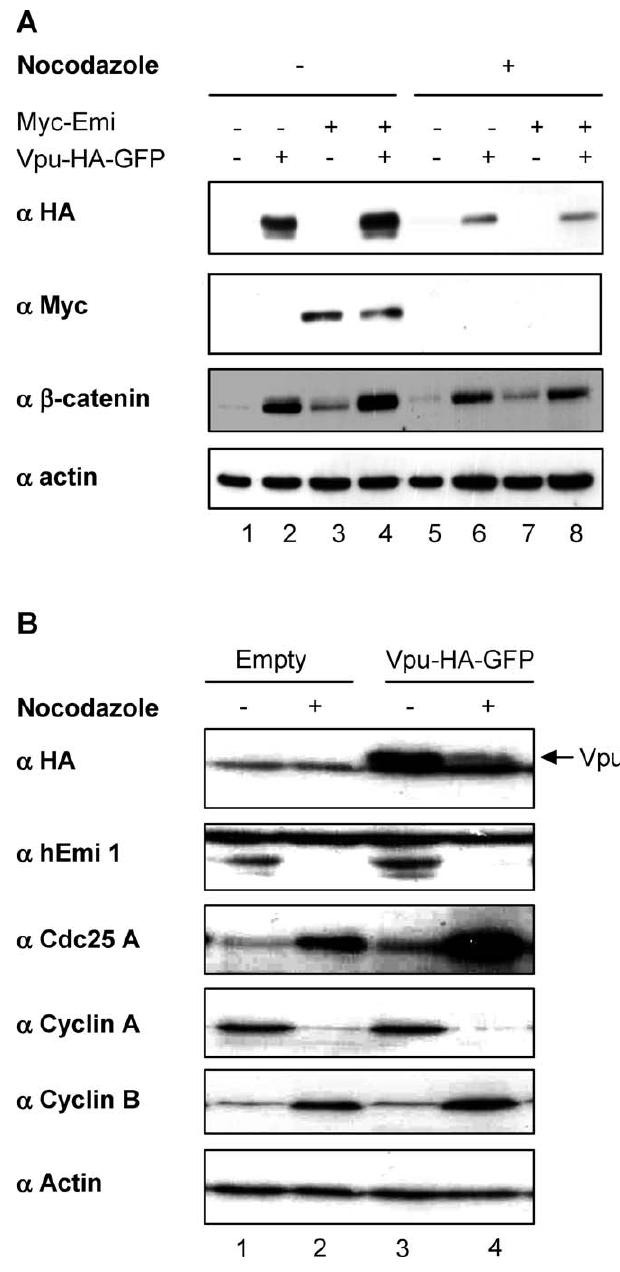
Figure 1. Vpu Is Degraded in Nocodazole-Treated Cells (A) Vpu does not affect Emi1 expression. HeLa cells were mock- transfected (lanes 1 and 5), or transfected with Vpu-HA-GFP alone